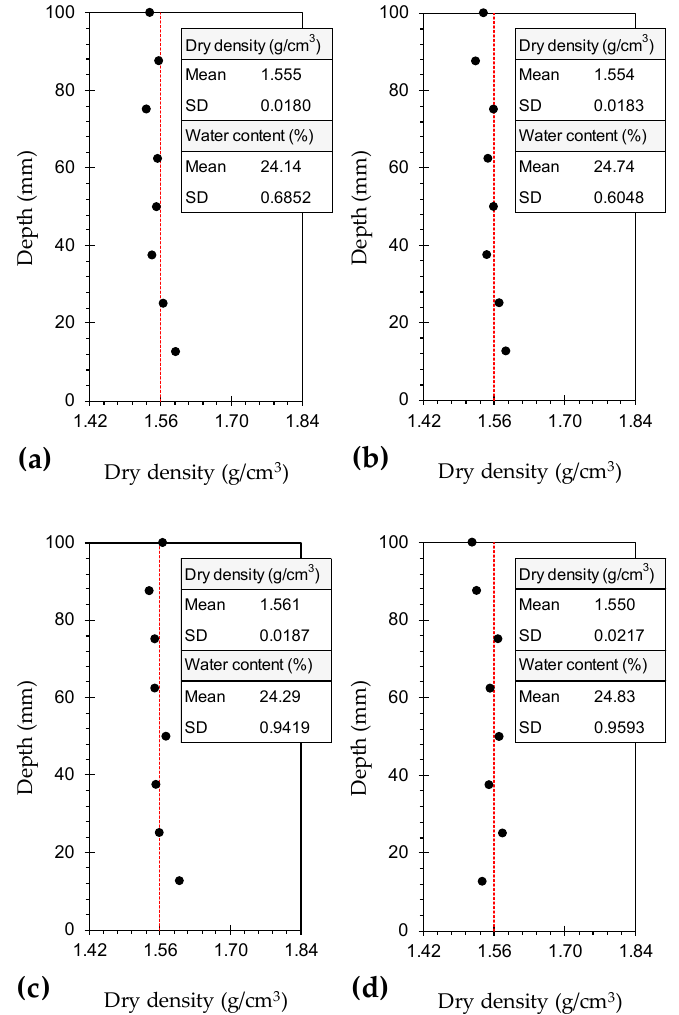
Figure 2. Variations of dry density along the height of the compacted samples: ( a ) F 0 S 0 T 0 ; ( b ) F 1.0 S 0 T 0 ; ( c ) F 0 S 6 T 0 ; and ( d ) F 1.0 S 6 T 0 .